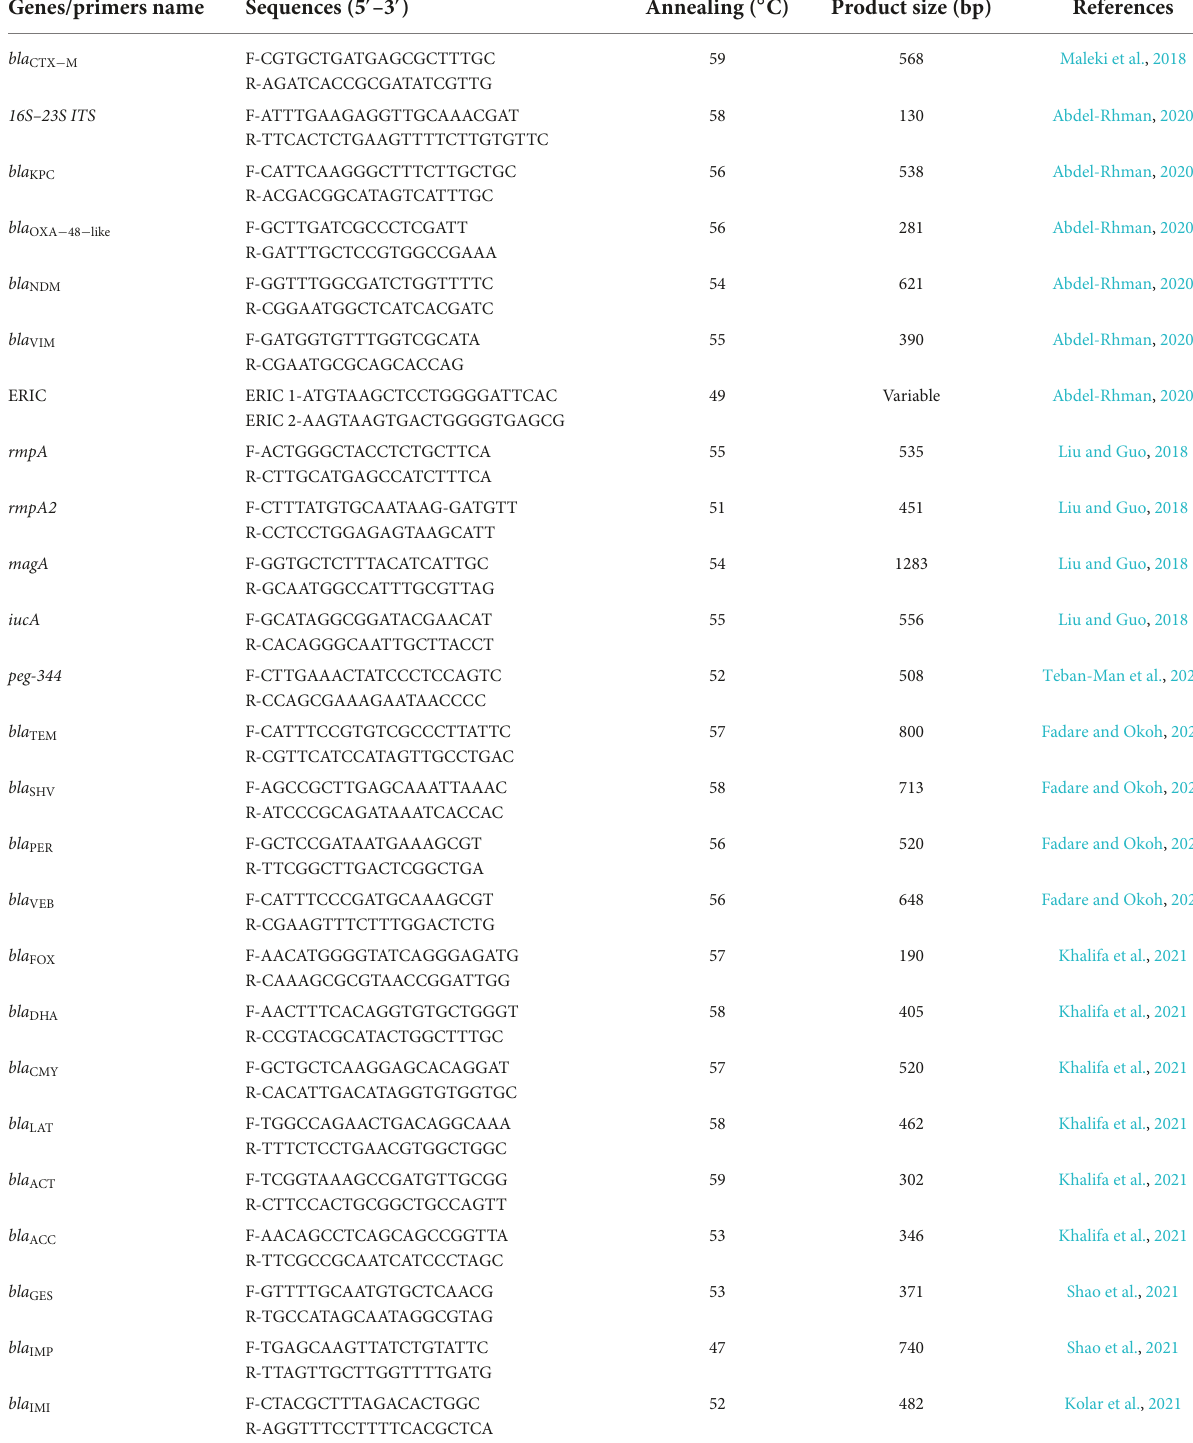
TABLE 1 The sequence of primers used in the polymerase chain reaction